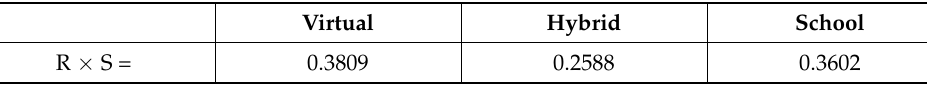
Table 9. Component Vector Weights for the 3